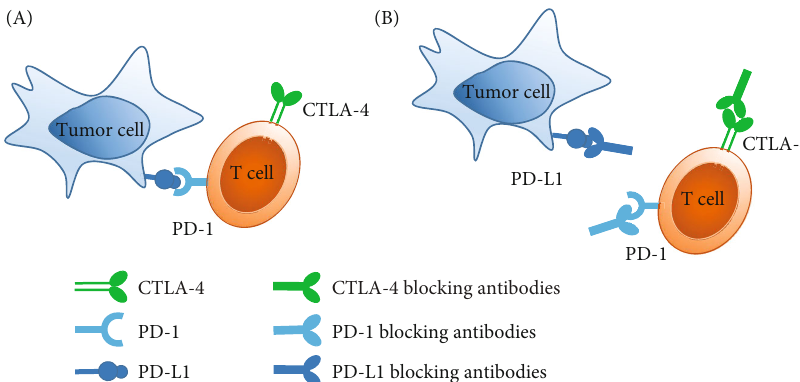
Figure 2: The brief antitumor mechanism of CTLA-4 and PD-1/PD-L1 blocking antibodies. (a) In the tumor microenvironment, the T cell surface is highly inhibited by inhibitory immunoregulatory receptors, such as CTLA-4 and PD-1/PD-L1, which prevents the immune activation of T cells and the killing of tumors. (b) The use of PD-1/PD-L1 or CTLA-4 blocking antibodies can eliminate the immunosuppressive e ff ects of PD-1/PD-L1 or CTLA-4, thereby activating the immune response of T cells to kill